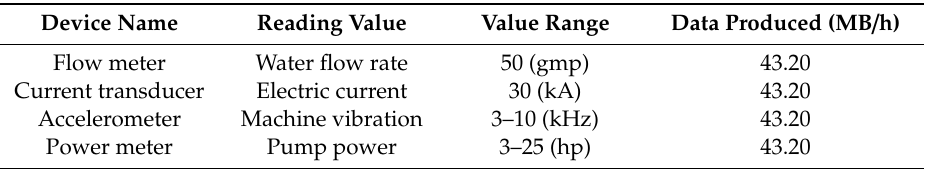
Table 1. Devices deployed with the smart